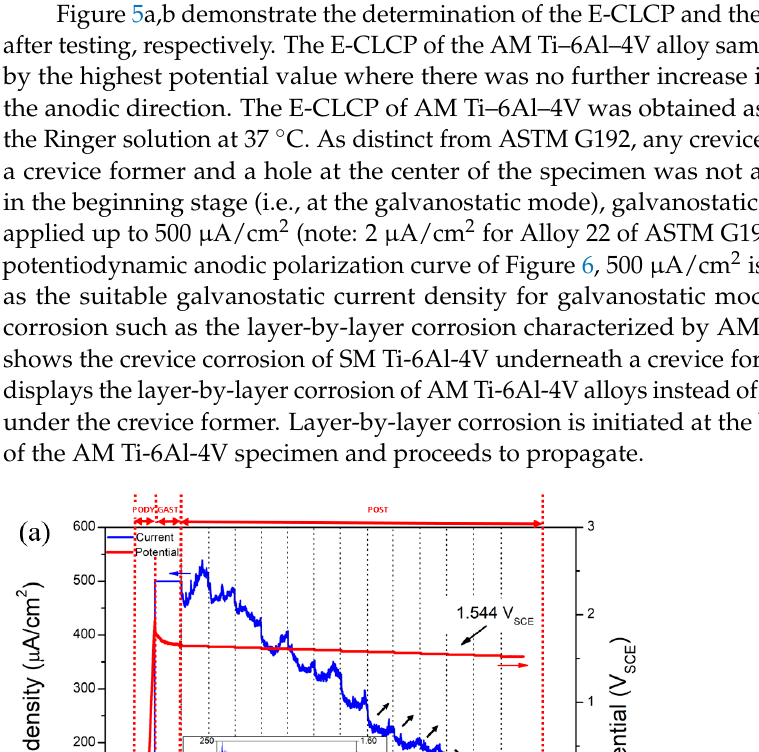
Figure 5. ( a ) Determination of E ‐ CLCP values for the as ‐ received AM Ti–6Al–4V alloy at 37 °C in Ringer solution (note that the small arrow indicates the direction of current flow); ( b ) the shape of the layer ‐ by ‐ layer corroded area of the as ‐ received AM Ti–6Al–4V alloy. Inset is the magnified area around E ‐ CLCP for the corresponding graph. (PODY: potentiodynamic; GAST: galvanostatic; POST: potentiostatic polarization).